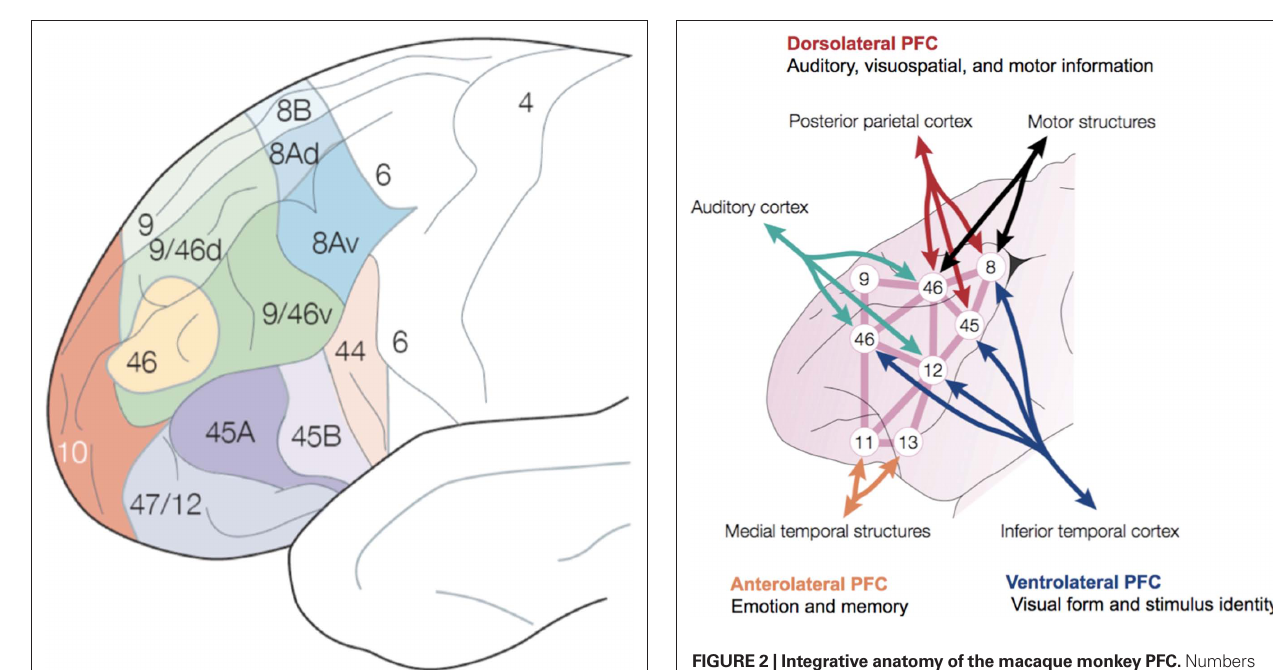
Figure 2 | integrative anatomy of the macaque monkey PFC. Numbers refer to subregions within the lateral PFC defined by Brodmann. Modified with permission from